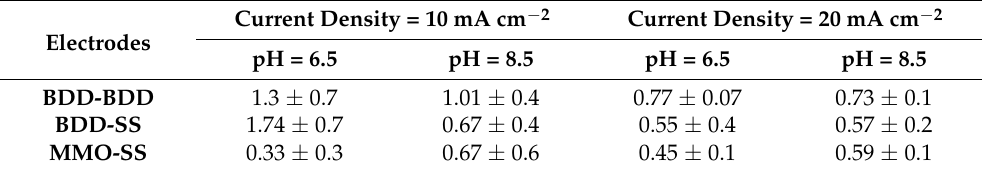
Table 5. COD/TOC ratio for different electrode configurations, pH and current